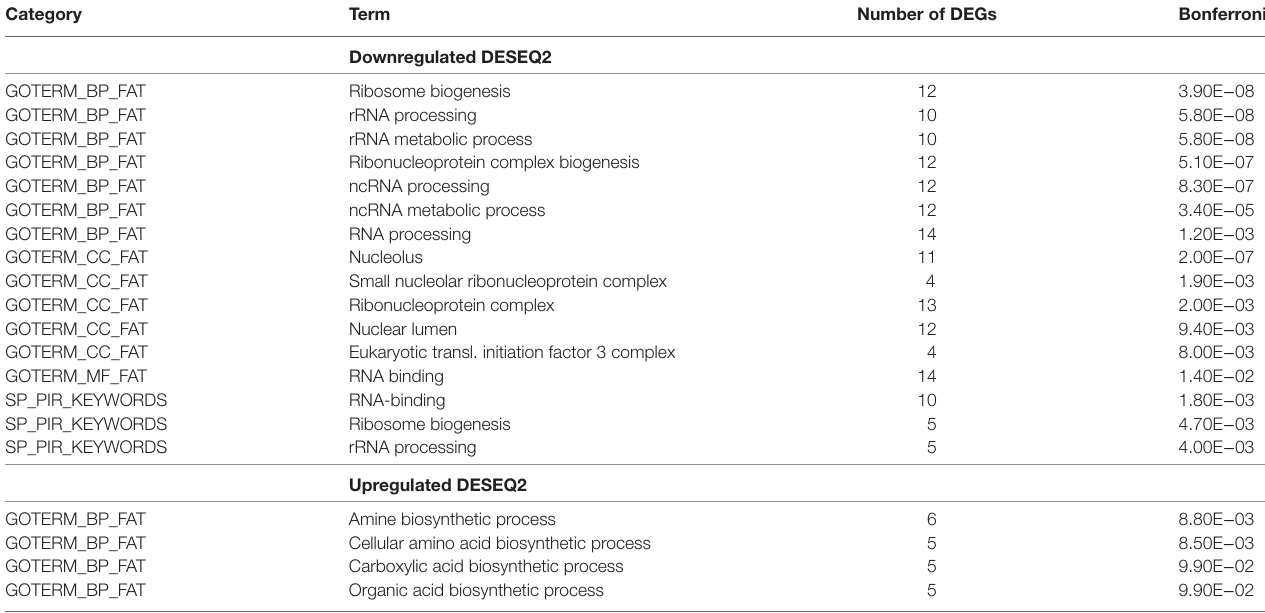
Table 7 | Bonferroni correction for differentially expressed genes (DEGs) enriched functionalities.